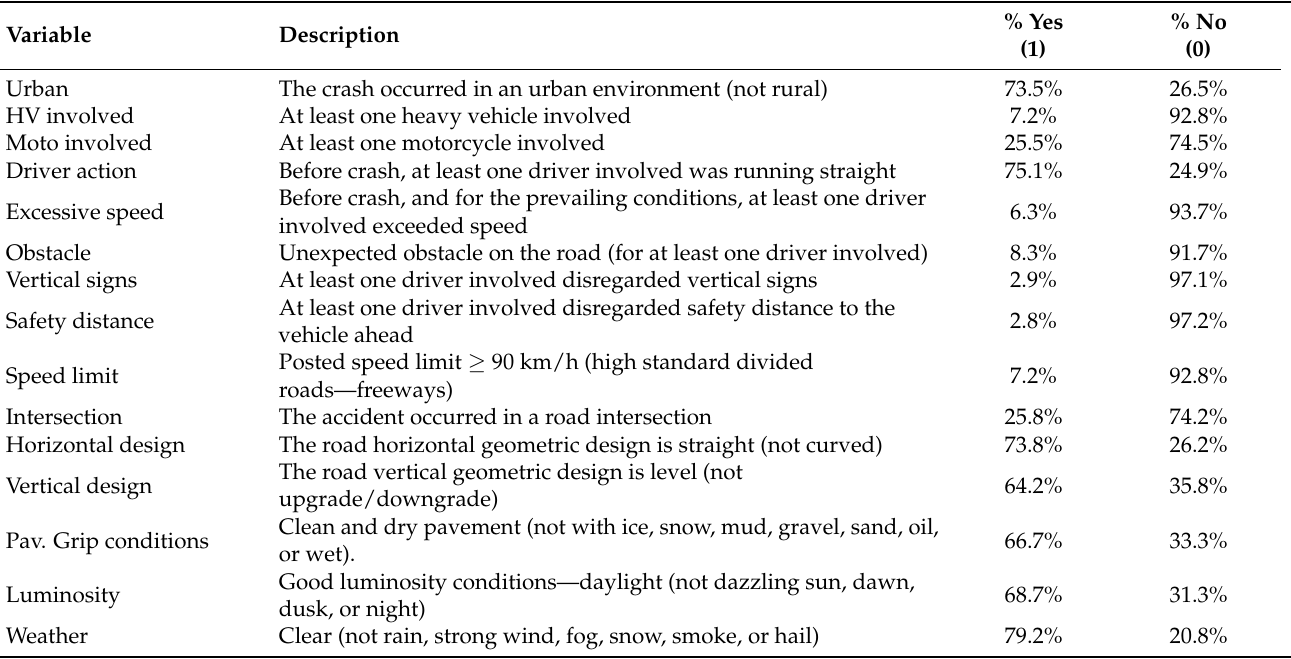
Table 3. Descriptive statistics of the explanatory variables used in models and assigned binary